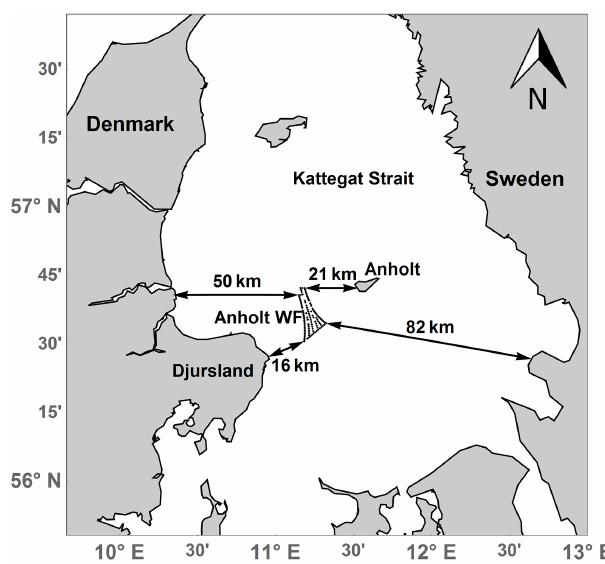
Figure 1. Position of the Anholt wind farm (Anholt WF) and dis- tances to the